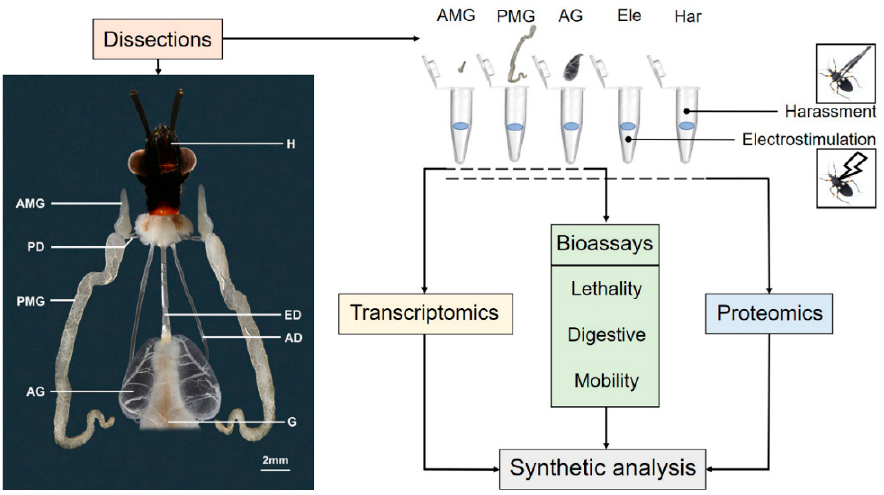
Figure 1. The structure of the salivary gland of Platymeris biguttatus in a ventral view. Schematic workflow of combined transcriptomic, proteomic, and toxicological assays of the salivary gland of Pl. biguttatus . Abbreviation: AD, accessory duct; AG, accessory gland; AMG, anterior main